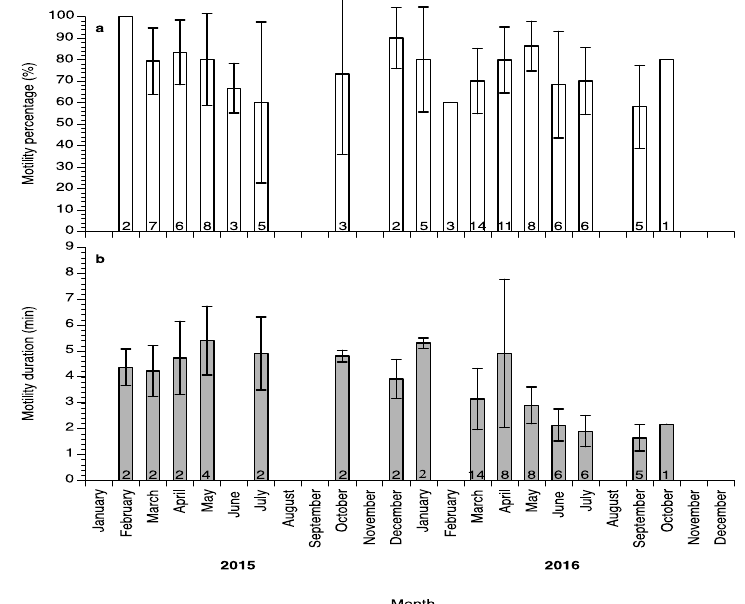
Figure 6. Mean (±SD) sperm motility percentage ( a ) and sperm motility duration ( b ) of sperm collected from wreckfish between February 2015 and October 2016. Different numbers inside the bars indicate the number of sperm samples used for each sperm quality parameter.